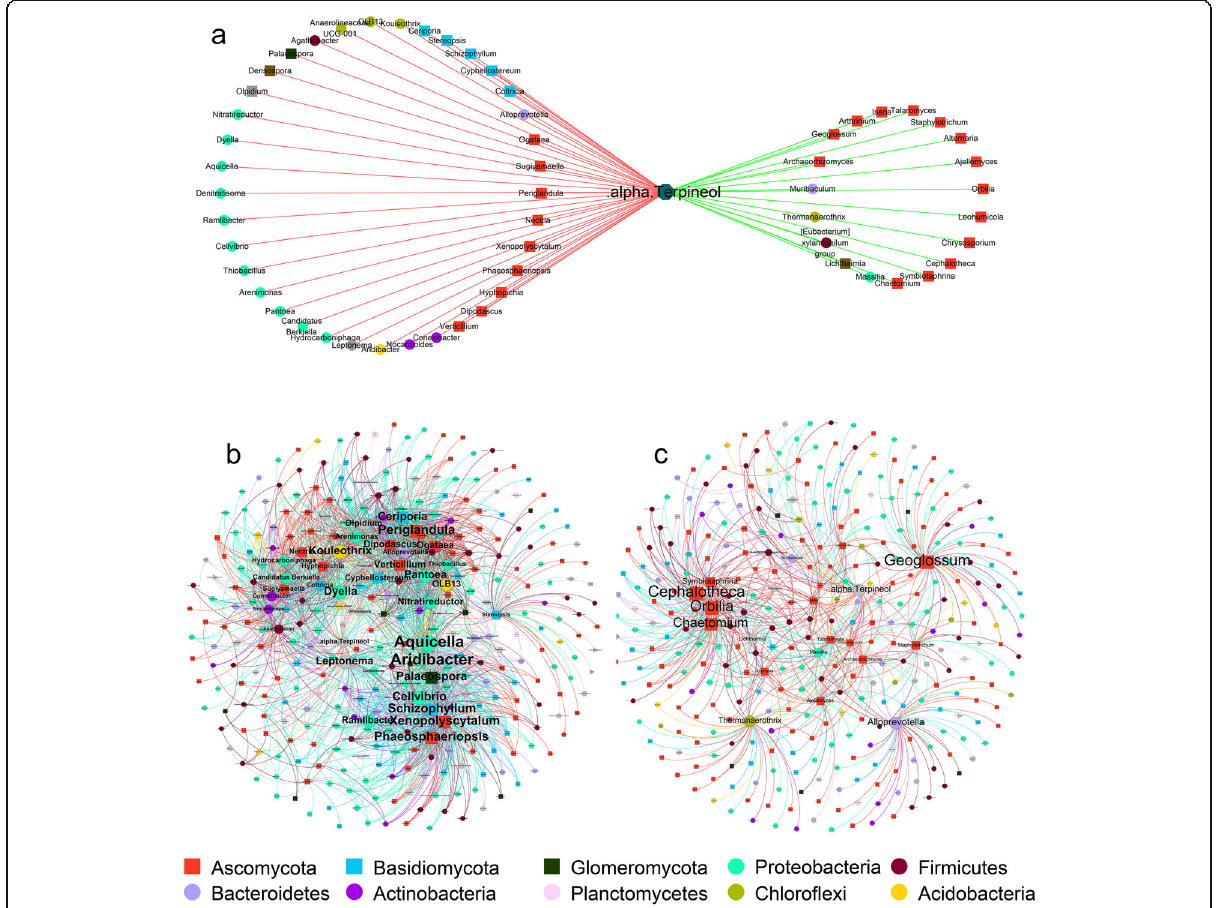
Fig. 5 Network analysis showing the correlations between α -terpineol and microbial communities. a Direct correlations between α -terpineol and fungi or bacteria at the genus level; red and green lines represent significant positive ( P < 0.05) and negative ( P < 0.05) linear relationships, respectively. b and c Co-occurrence networks between the 56 genera that were significantly correlated with α -terpineol (directly correlated) and other genera that were not significantly correlated with α -terpineol but significantly correlated with these 56 genera ( P < 0.05 and Pearson ’ s |R| > 0.6). The complicated co-occurrence network was divided into positive ( b ) and negative ( c ) networks according to the correlations of 56 genera with increasing concentrations of α -terpineol. Squares and circles represent fungi and bacteria, respectively. The size of a node and its label are proportional to the number of connections. Different phyla (nodes) use different colors, with the lines colored same as source